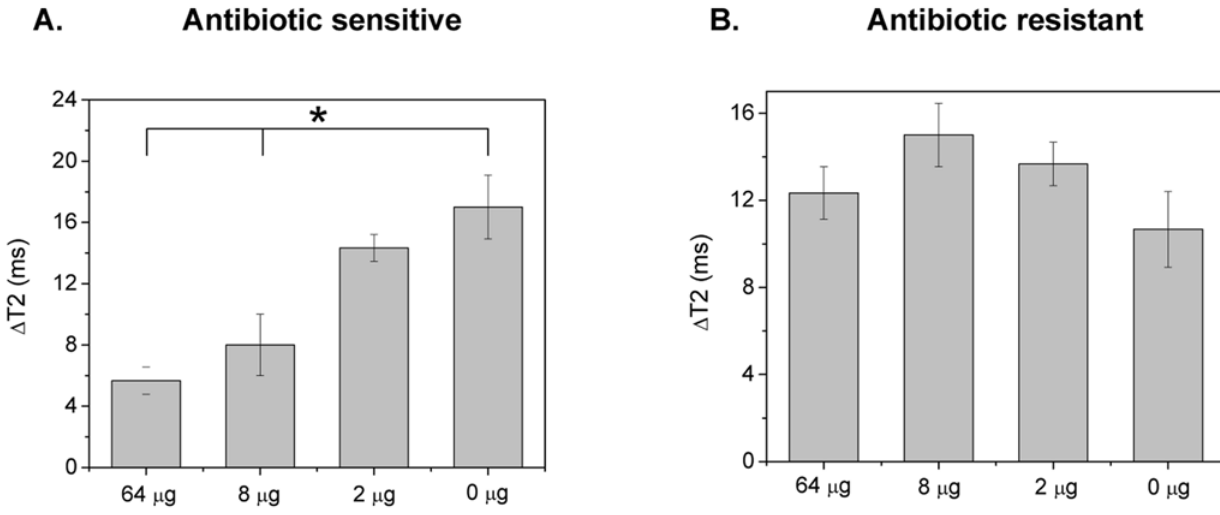
Figure 7. Antimicrobial susceptibility in blood using Con A-conjugated polysaccharide nanosensors. (A) Determination of E. coli ’s ampicillin MIC in blood, and (B) determination of Serratia marcescens ’ drug resistance in blood with the Con A-conjugated polysaccharide nanosensors, five minutes after addition of the bacterial aliquot into the nanoparticle solution (Means 6 SE; p , 0.05).